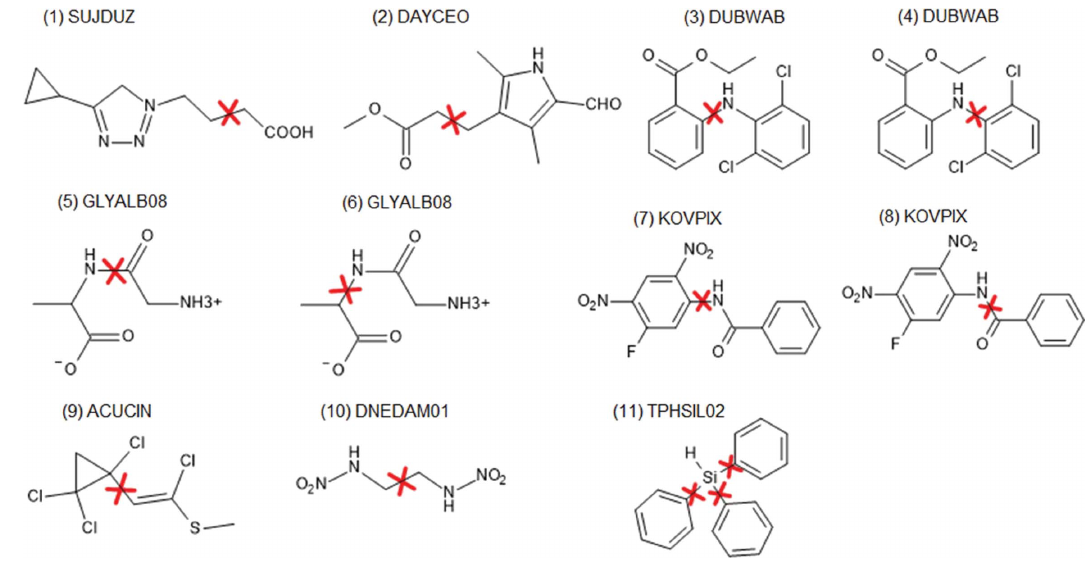
Figure 6 Molecules used for testing fragmentation. The red crosses indicate the bonds where the molecules were split into fragments.